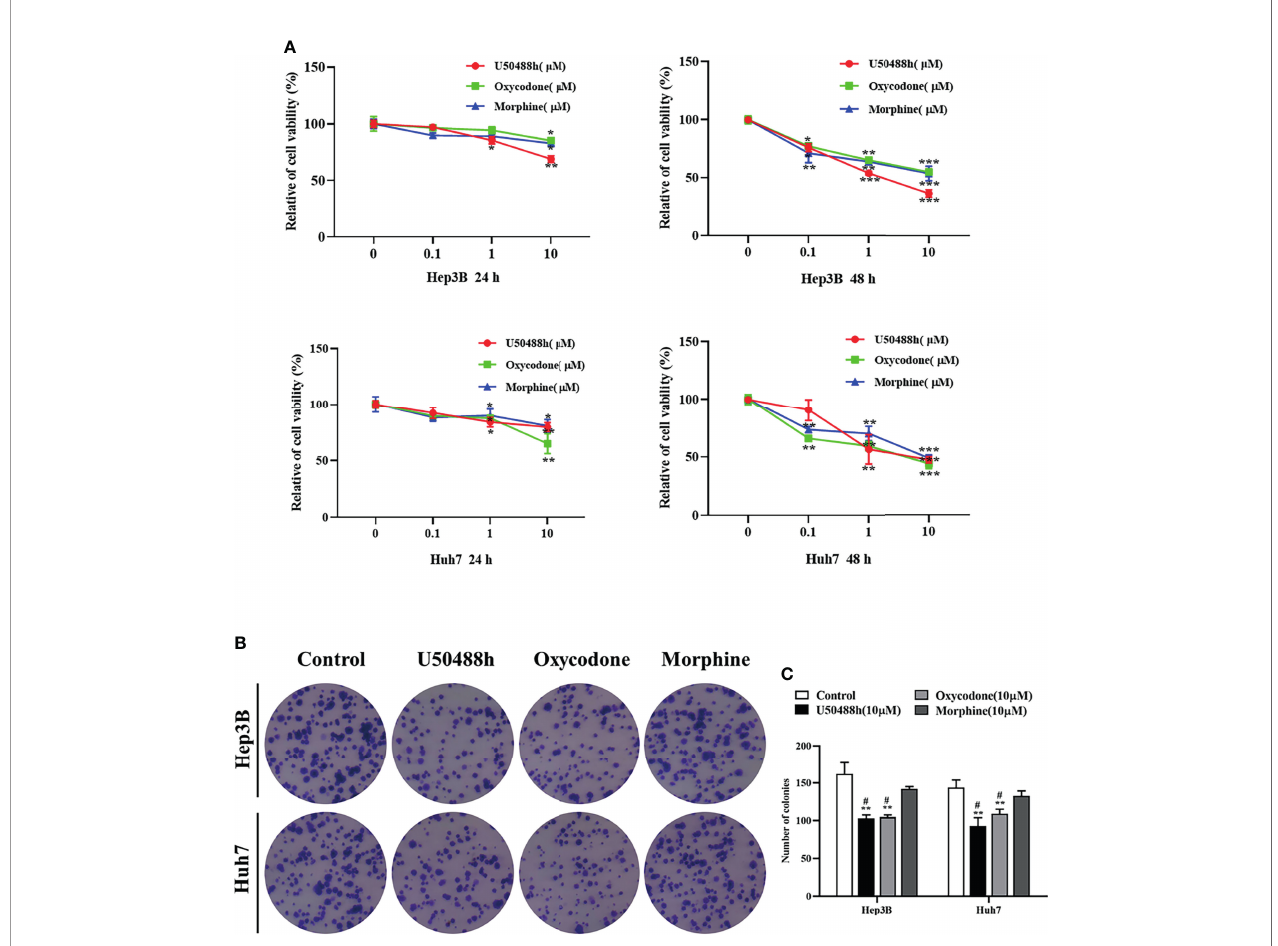
FIGURE 2 | KOR agonist inhibits proliferation in HCC cells. (A) Hep3B and Huh7 cells were treated with the KOR agonist U50488h (0,0.1,1, and 10 m M), the mixed agonist oxycodone (0,0.1,1, and10 m M) and the selective MOR agonist morphine (0,0.1,1, and10 m M) for 24 h and 48 h, and CCK-8 assay was performed to assess cell viability. (B, C) Hep3B and Huh7 cells were treated with U50488h (10 m M), Oxycodone (10 m M) and Morphine (10 m M) for 48 h for colony formation assay. Values are presented as the mean ± standard deviation of three independent experiments. *P < 0.05, **P < 0.01, ***P < 0.001 vs. control group; # P < 0.05 vs. Morphine